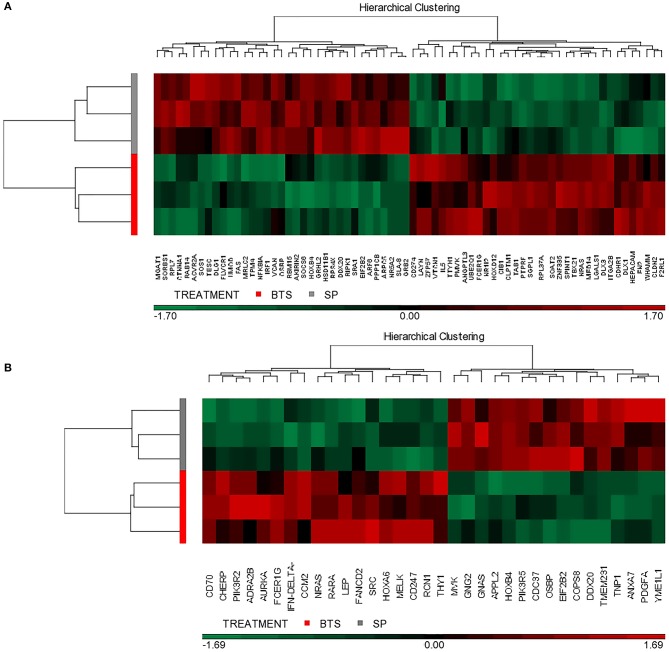
Hierarchical cluster analysis of gene expression patterns. The selected transcriptional profiles (DAVID database) were obtained from the distal (A) or proximal (B) regions of the uterine horn endometrium collected 6 days after heterologous seminal plasma (SP) or BTS (control) infusions prior to insemination. Colors correspond to relative RNA abundance for the detected genes, each of which is represented by one vertical bar. Red color indicates upregulated expression and green downregulated expression while black indicates the mean value.